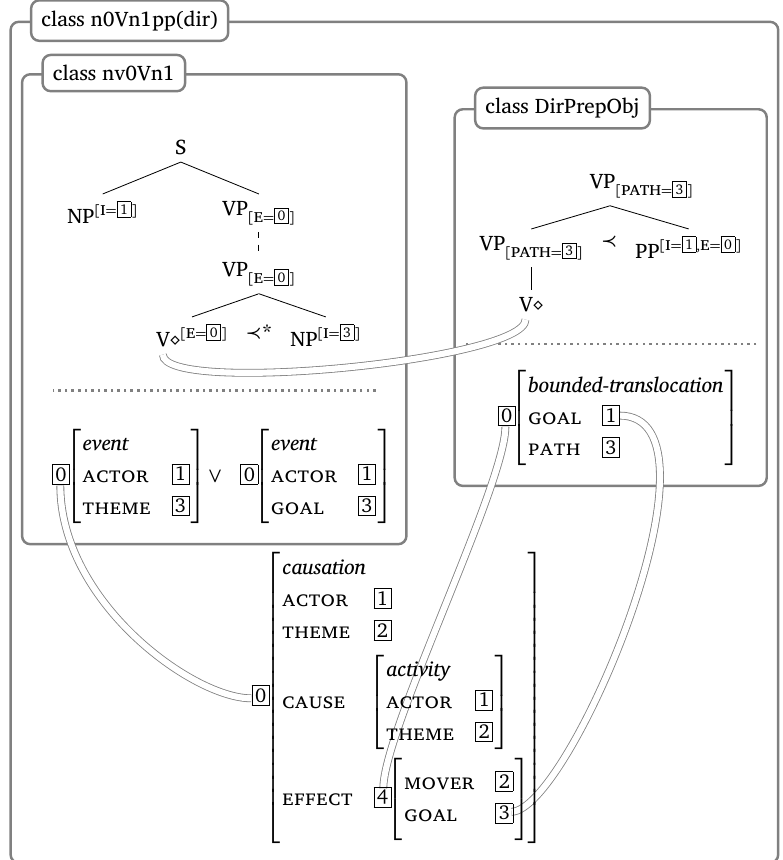
Figure 4: Metagrammatical factorization of the elementary construction from Figure 2. Boxes stand for the resulting factors or classes. Double edges indicate identity constraints, dashed edges indicate non-strict dominance, ≺ * is non-strict precedence, and _ is